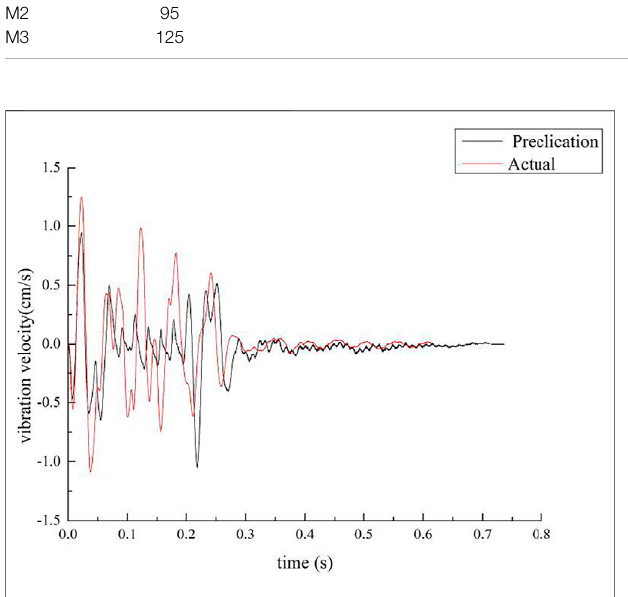
FIGURE 3 | Simulation and measurement of group-hole blasting vibration waveform at point M1.